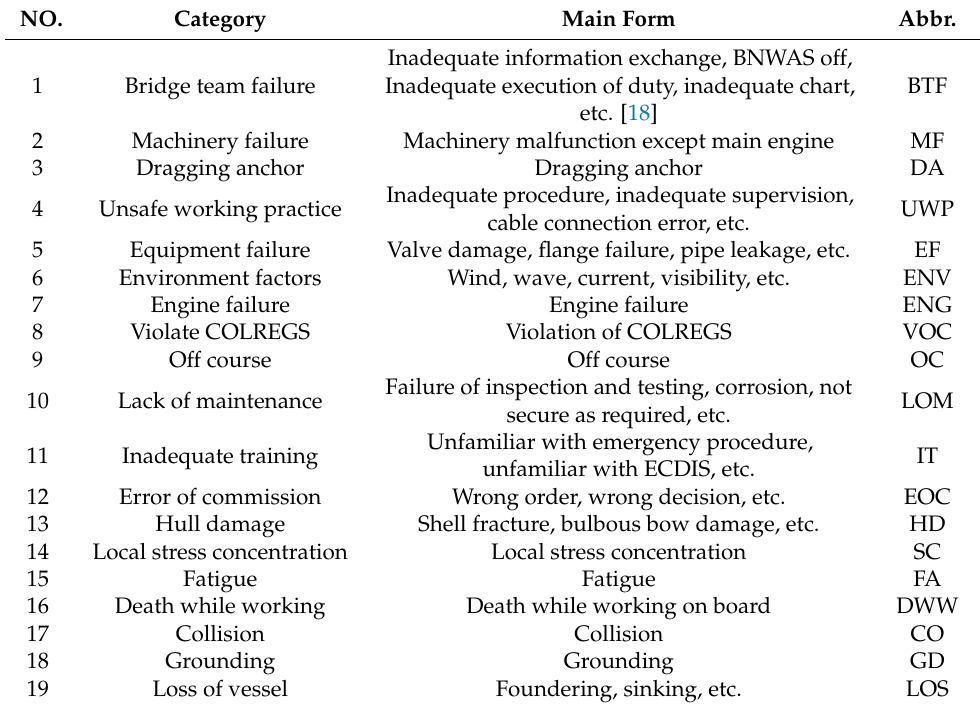
Table 2. Factors of abbreviation in